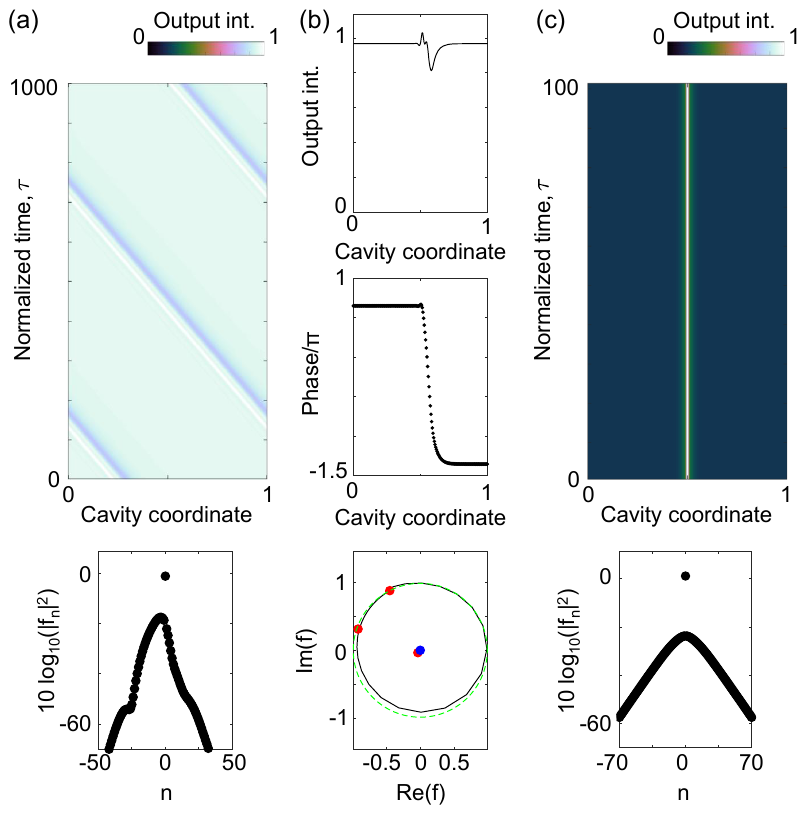
If we move on the upper branch from the right to the left crossing the bifurcation point MI, we observe the onset of Turing rolls, whose maximum and minimum intensity are shown by the red symbols in Figure 5. At Y = 82, the Turing pattern becomes unstable and one or more CSs emerge from it. The blue symbols indicate the maximum intensity of the CSs along their branch. Figure 4(c) shows a CS at steady state for Y = 100. In Figure 3, the curves θ and θ for G = Δ (solid line) IL1 MI1 intersect at a point whose abscissa can be calculated (cid:4) √ ) / 3 ≃ 2 . 125. For smaller Δ , analytically and it is Δ (cid:1) ( 4 + 7 if Y coincides or is close to Y SN in such a way that the MI 1 upper branch is modulationally unstable between the two turning points, the lower branch is entirely unstable and no stable stationary CSs exist. The picture changes if we allow G to be different from, and in particular larger than, Δ , i.e. if G = Δ + ζ with ζ > 0, which means that GVD is not negligible and dispersion is anomalous. In Figure 3, the two dashed red curves have been obtained setting G = Δ + 1. They are displaced to the left with respect to the solid curves ob- tained with G = Δ and now the curve θ intersects thecurve IL1 ≃ Y and θ = 4.7 (point c of Figure 3), we have Y and yet a MI SN1